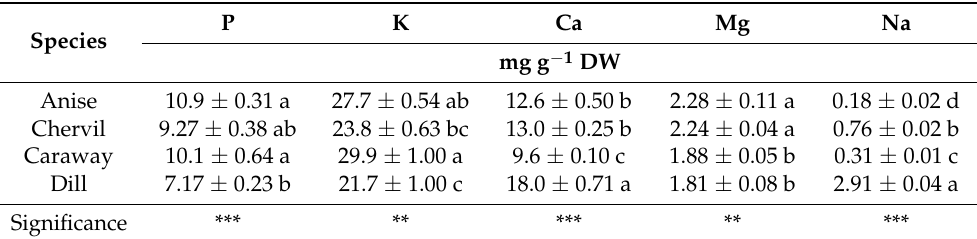
Table 1. Macromineral content of four Apiaceae species of microgreens grown in controlled environ- ment conditions. P K Ca Mg Na Species mg g − 1 DW Anise Chervil